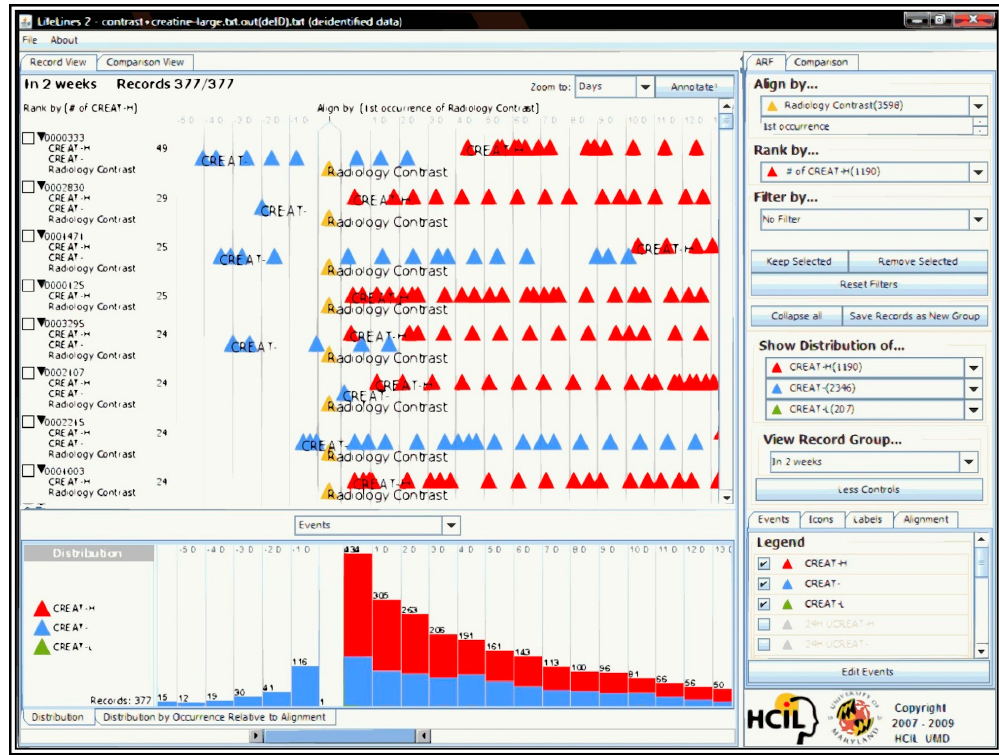
Figure 4. Lifelines2: Interactive visualization tool for temporal categorical data. Source: Image courtesy of the University of Maryland Human–Computer Interaction Lab , http://hcil.umd.edu.